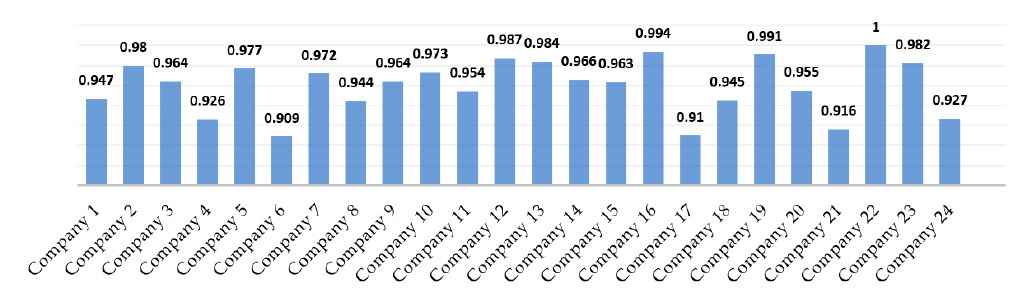
Figure 8. Average of total efficiency for the CCR model.